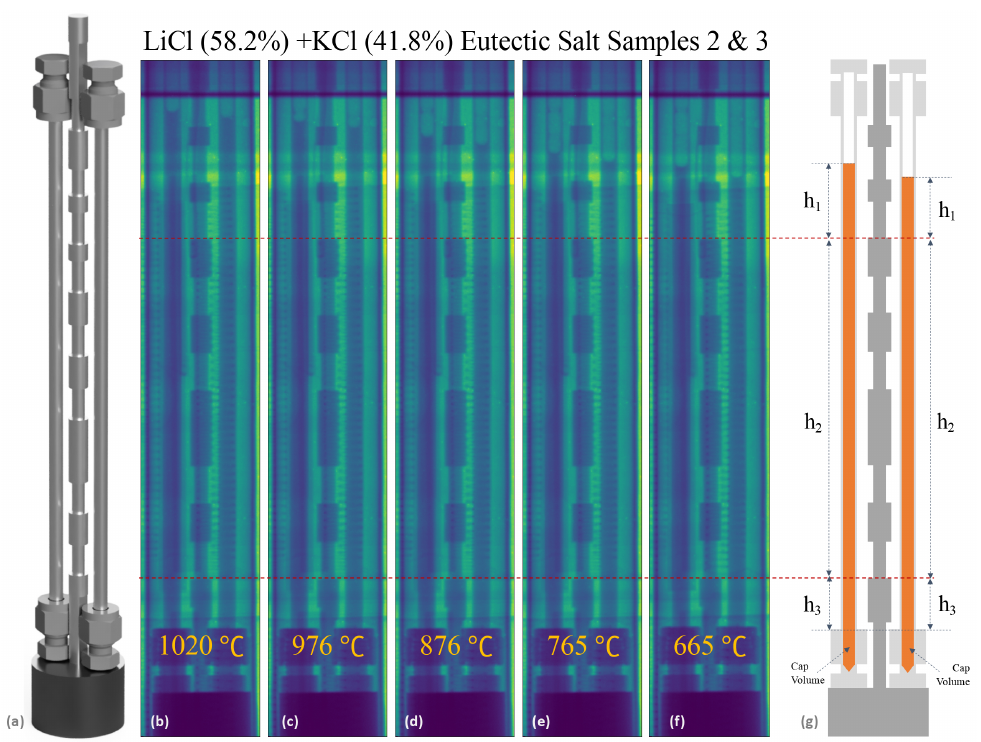
Figure 3. ( a ) A CAD rendering of 0.25” inch OD Swagelok tube containers along with the sample holder that acts as a calibration ruler. ( b – f ) Composite radiographs of two LiCl + KCl eutectic samples (2 and 3) taken at various temperatures 1020–665 ◦ C). ( g ) Diagram illustrating how heights of menisci are determined relative to the sample